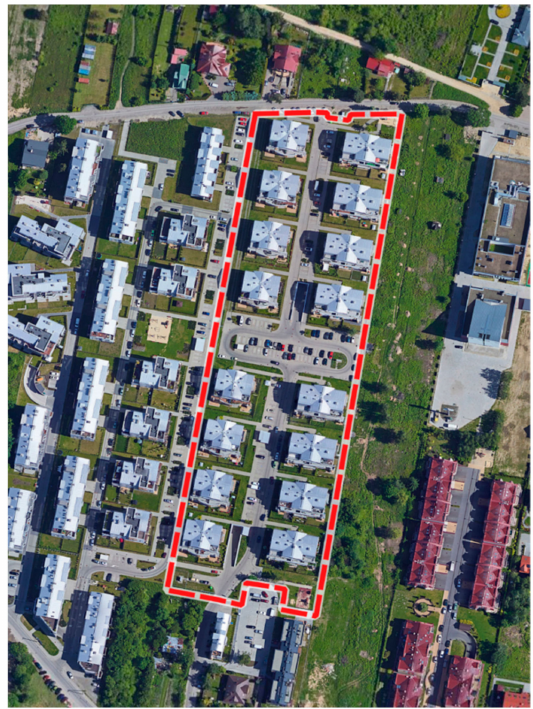
Figure 1. The land use and boundaries of the housing estate area included in the analysis